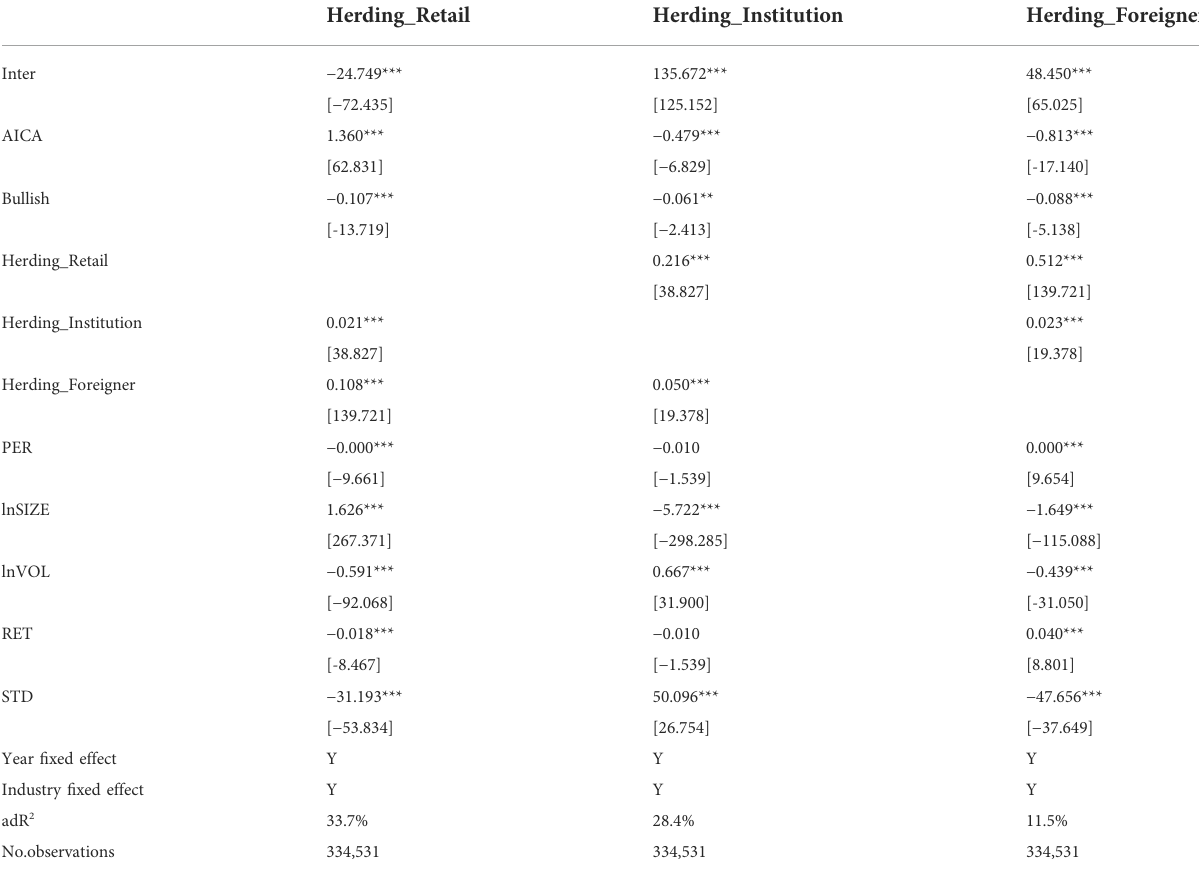
TABLE 3 Relationship between investor herding behavior and Bullish. Table reports the impact on Bullish on the retail, foreign and institutional investor herding measures. This table presents the parameter in Eq. 6. Herd_Retail, Herd_Foreigner and Herd_Institution are retail, foreign and institutional herding behavior measures, respectively. Bullish is an investment sentiment indicator that represents the opinion score. AICA is the abnormal ICA. lnSIZE is the value taking the natural log of market capitalization. PER is the P/E ratio. lnVOL is the value taking the natural log of the trading volume. STD is the standard deviation of daily returns from the previous 3 months. The industry and the year effect are